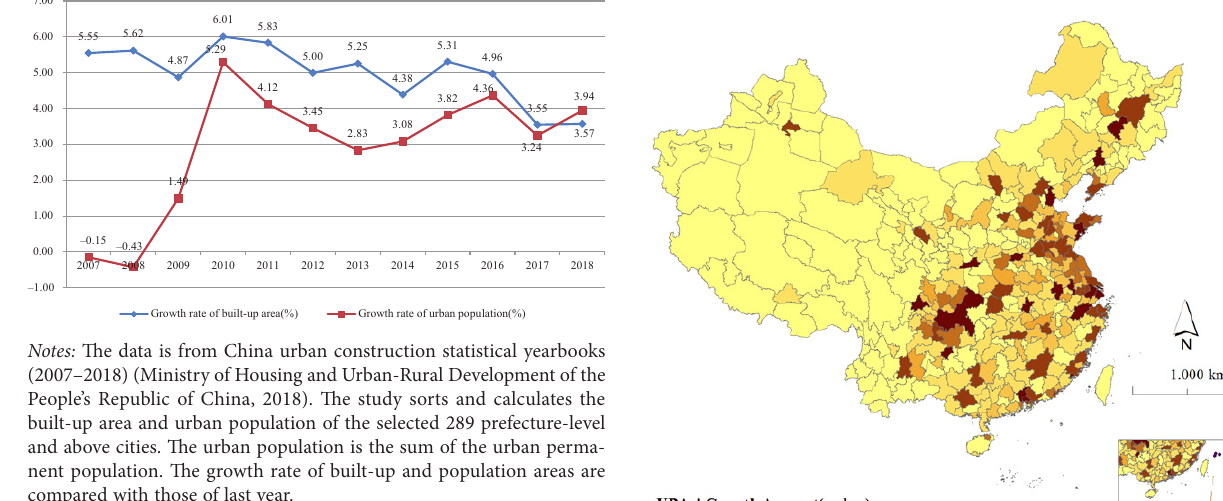
Figure 1. Growth rate of built-up areas and population in 289 cities in 2007–2018